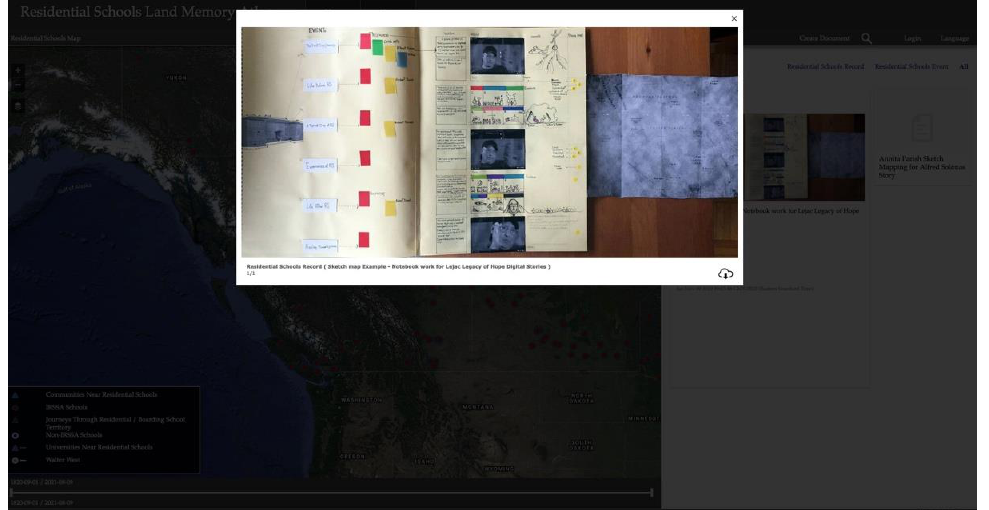
Figure 3. Screenshot of the Residential Schools Map of the Residential Schools Land Memory Atlas, showing a full view of the sketch mapping work by Annita Parish (Available online: https://resi- dentialschoolsatlas.org/index.html?module=module.residential_schools#eyJ0IjoieCIsIm- kiOiJkZGQ4NjM1NDJjZjExMDE5YzM2MDRhNzc2NzYzNTA2MSIsInMi- OjE2NDQ4NjQ2OTA5MzV9, (accessed on 1 April 2022)).